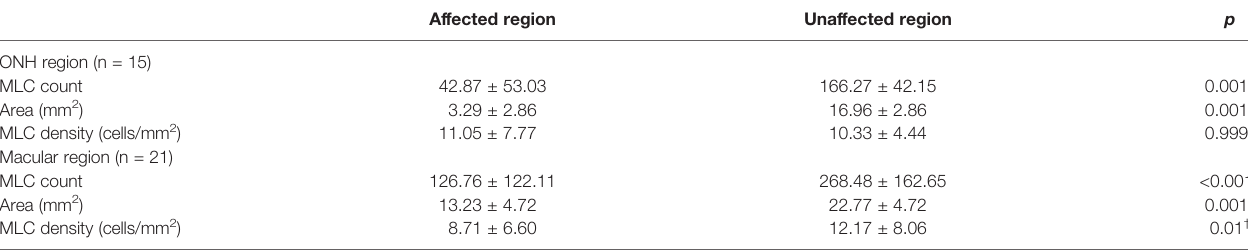
TABLE 3 | MLC parameters and retinal parameters in the occlusion-affected and unaffected regions of BRVO eyes.